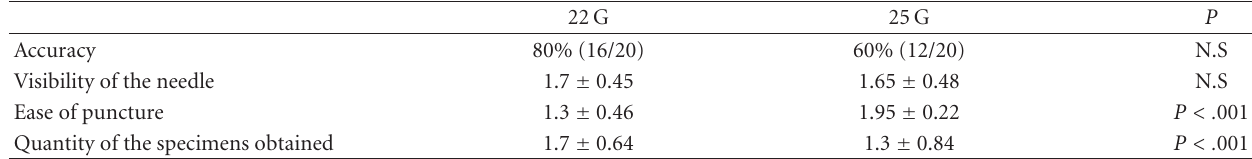
Table 4: Comparison of EUS-FNA of submucosal tumours with the 22-gauge and 25-gauge needles. 22G